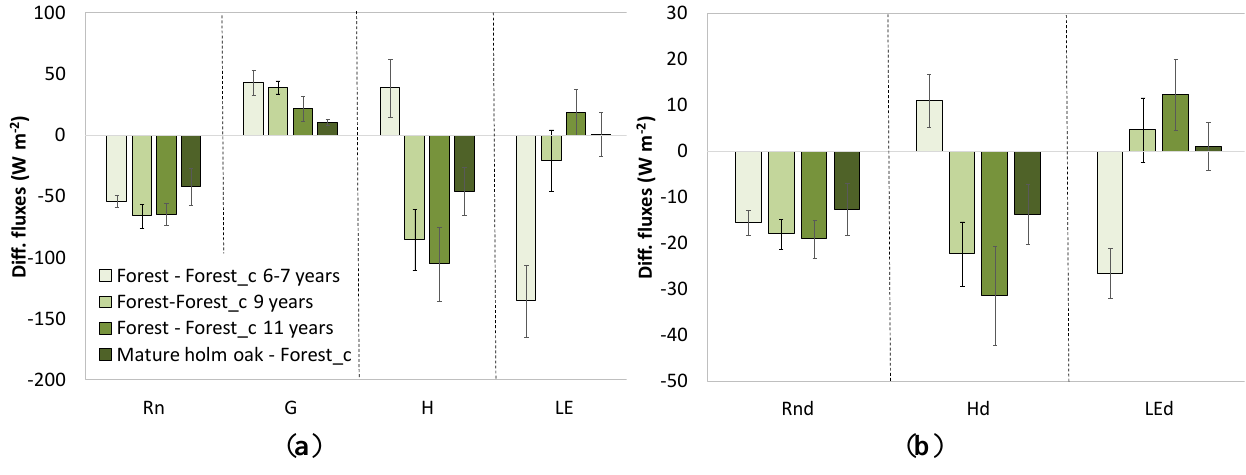
Figure 7. Average values of the differences between burnt and unburnt forest, and between forest and mature holm oak areas, in terms of R n , G , H , and LE : ( a ) Instantaneous fluxes; ( b ) Daily fluxes. Error bars represent the standard deviations of the